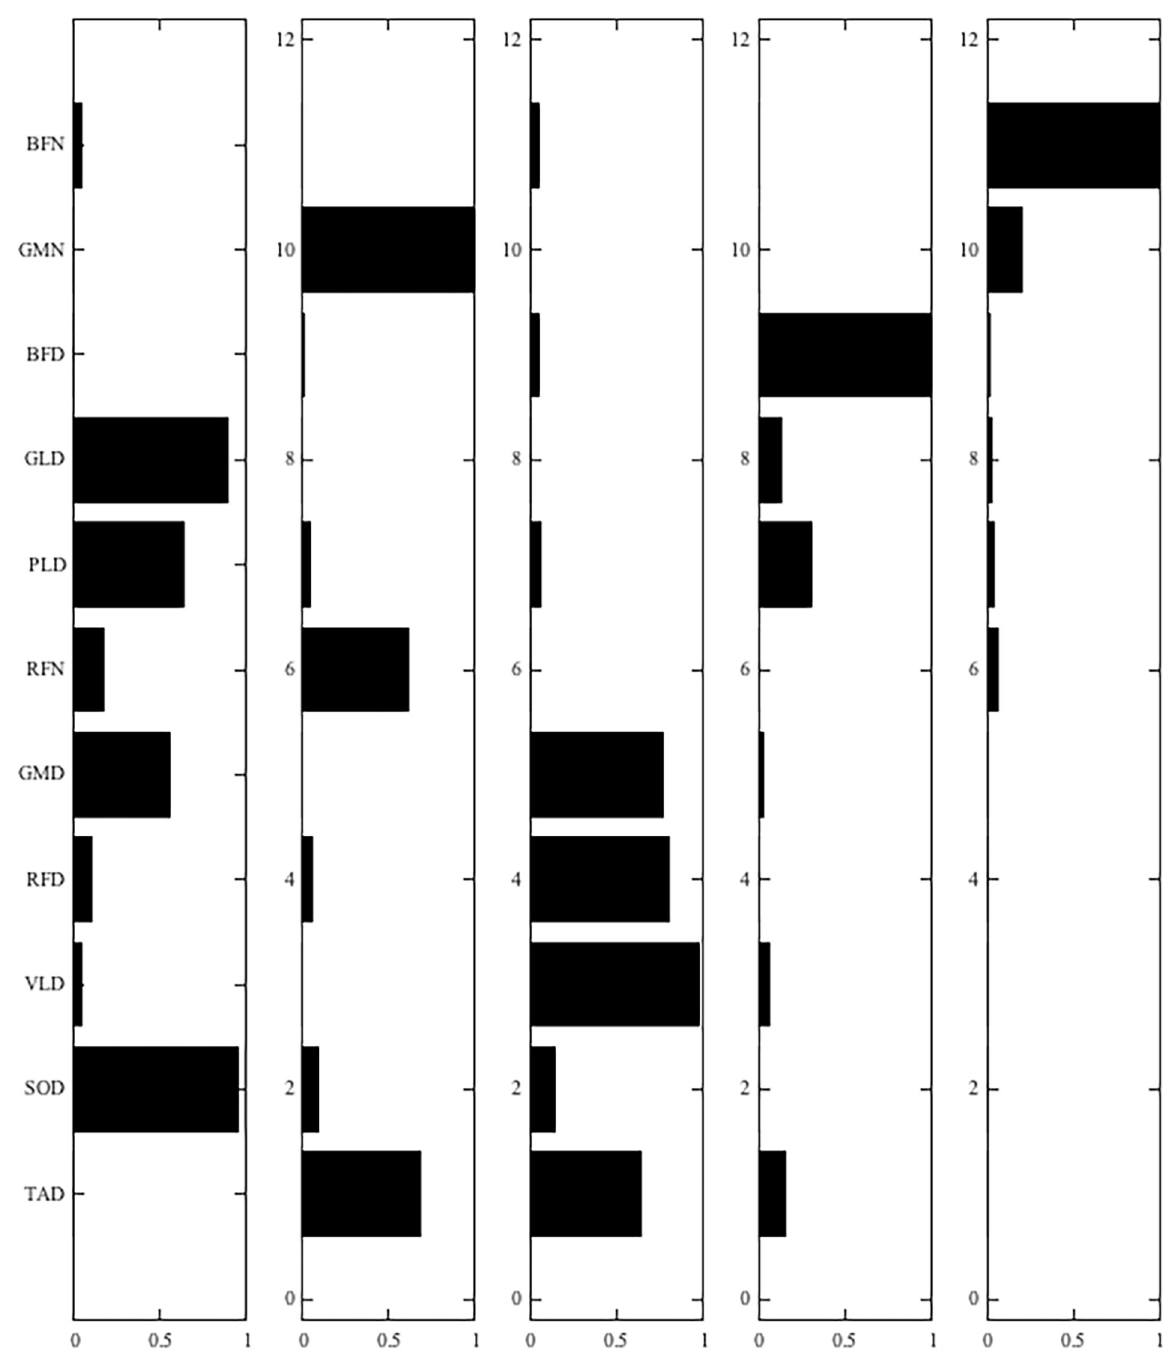
Fig 7. Time-invariant muscle weightings of synergies extracted from concatenated data, over all individuals, conditions, and time-points. Muscles monitored unilaterally on the dominant side (D): tibialis anterior (TA), vastus lateralis (VL), lateral gastrocnemius (GLD, soleus (SO), and peroneus longus (PLD). Muscle collected on the dominant (D) and non-dominant side (N): rectus femoris (RFD, RFN), biceps femoris (BFD, BFN), and gluteus medius (GMD, GMN).